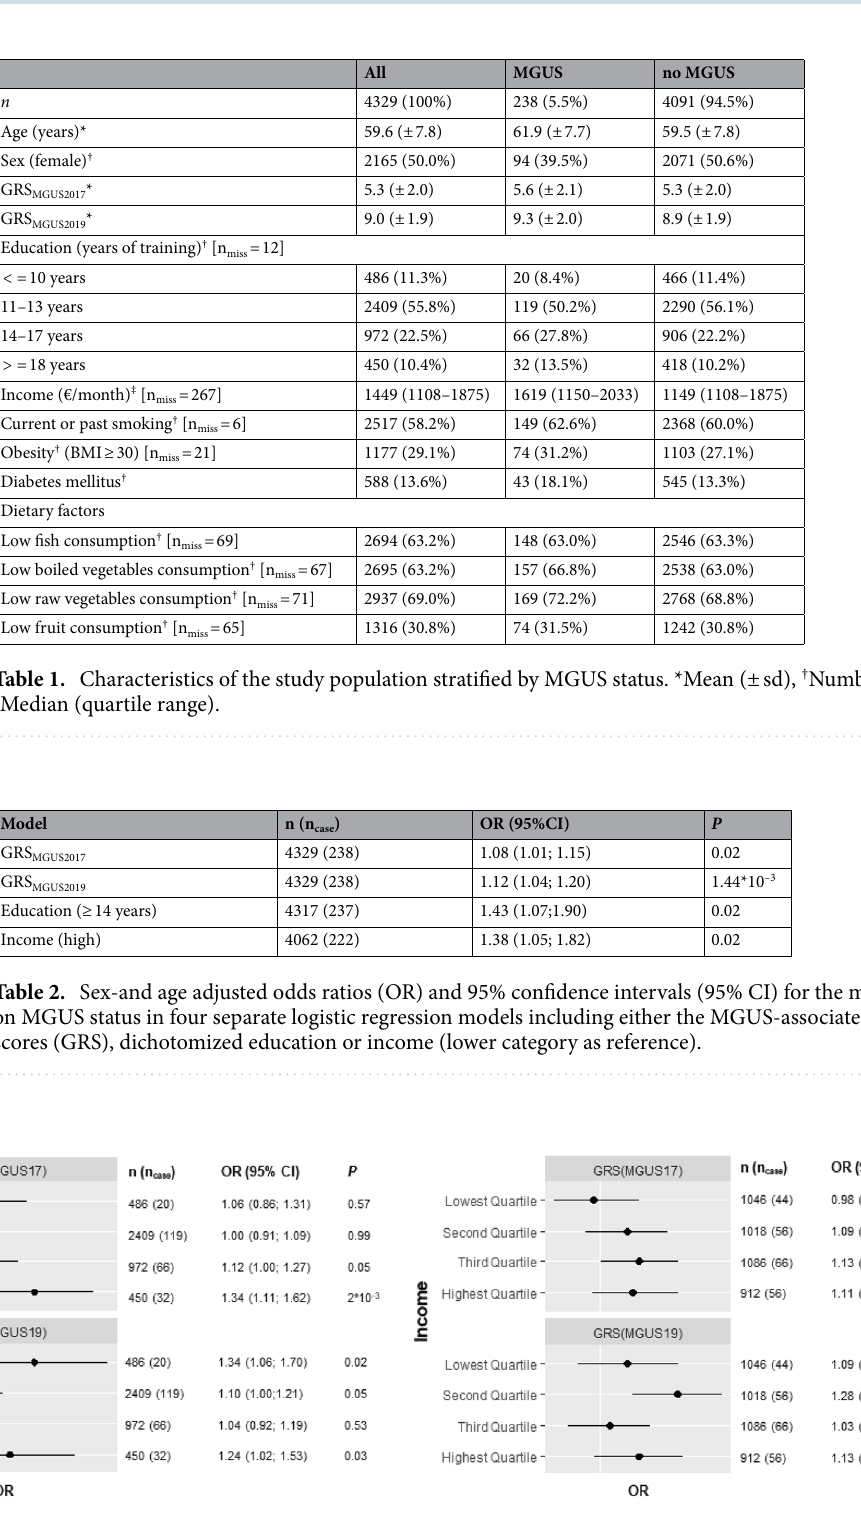
Figure 1. Sex-and age-adjusted odds ratios (OR) and 95% confidence intervals (95% CI) for the effect of genetic risk scores